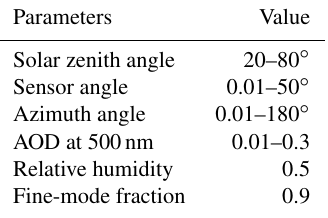
Table A4. Geometries and atmospheric parameters. All parameters conform to random uniform distributions in the specified ranges.